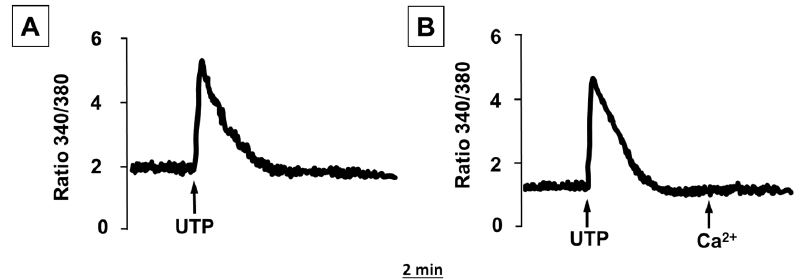
Figure 3. Effects of UTP on [Ca 2+ ] i concentrations in human differentiated white adipocytes. Human adipocytes, grown and differentiated in adipogenic medium on glass coverslips, were loaded with fura-2/AM as described in the Section 4. ( A ) Adipocytes suspended in Ca 2+ -containing medium. ( B ) Adipocytes suspended in Ca 2+ -free medium. Where indicated, UTP (100 μ M) and Ca 2+ (1 mM) was added. Traces are representative of the fluorescence ratio F340/F380 of a typical experiment of three. Among the different purine and pyrimidine nucleotides, ATP, ATP γ S, UTP, and α , β - methylene ATP induced a rise in [Ca 2+ ] i in human adipocytes, suggesting the functional activity of both P2XR and P2YR (Figure 4). ATP γ S, a non-hydrolyzable ATP analog, induced a rise in [Ca 2+ ] i quite similar to that induced by ATP, thus suggesting that ATP itself, rather than its degradation products (ADP, AMP, adenosine), is the native P2 receptor agonist in human adipocytes. Similarly, the addition of ADP had no effect on inducing the [Ca 2+ ] i increase in human adipocytes (Figure 4).